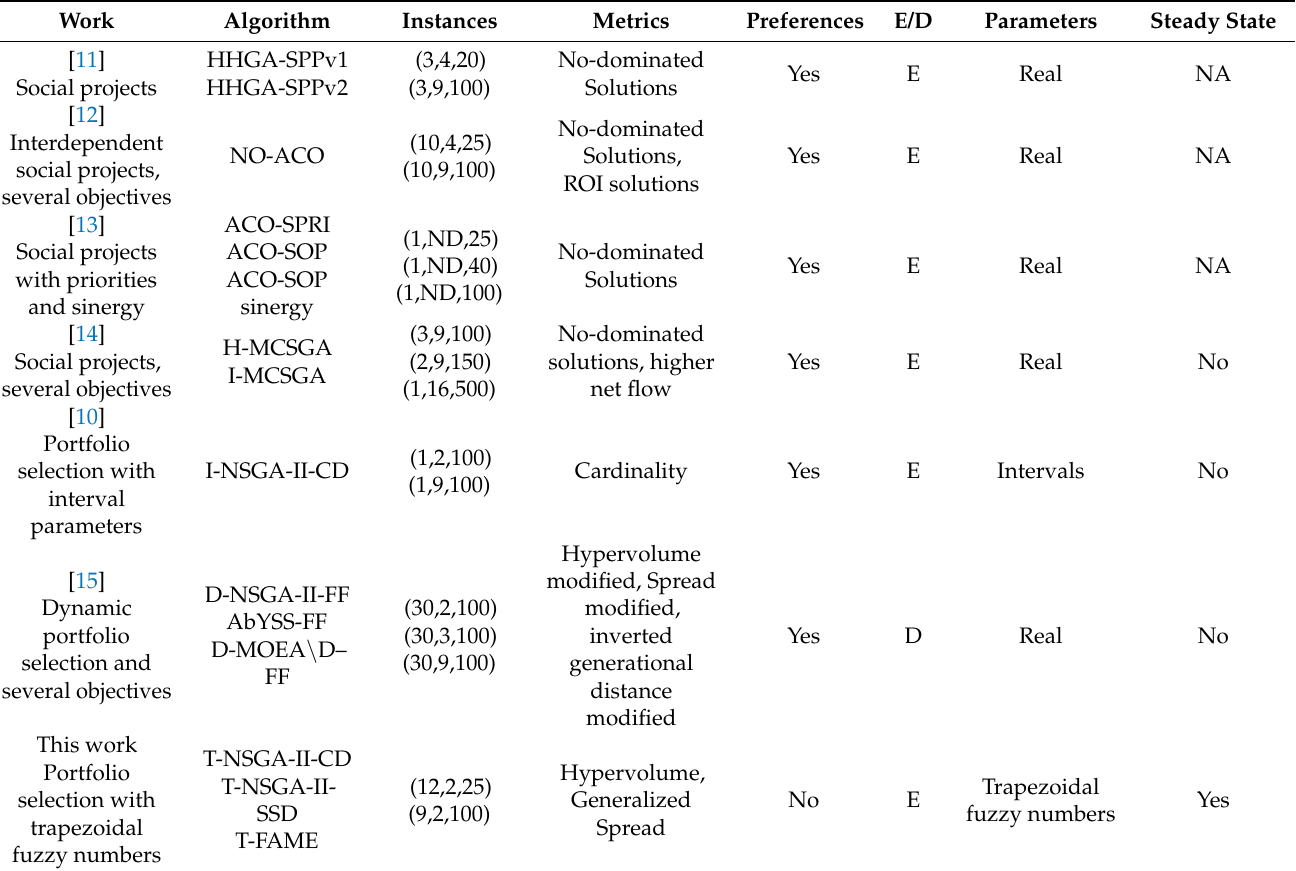
Table 1. Related